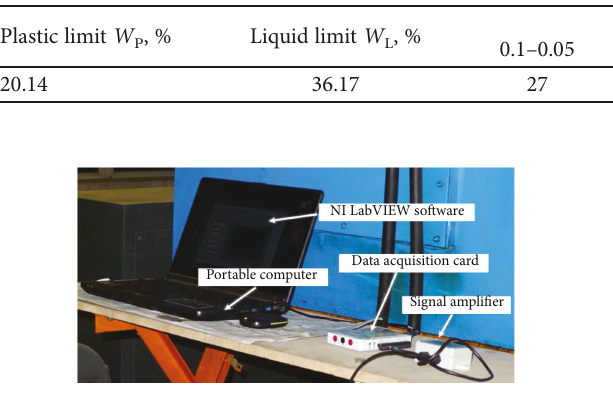
Figure 9: Data acquisition system.